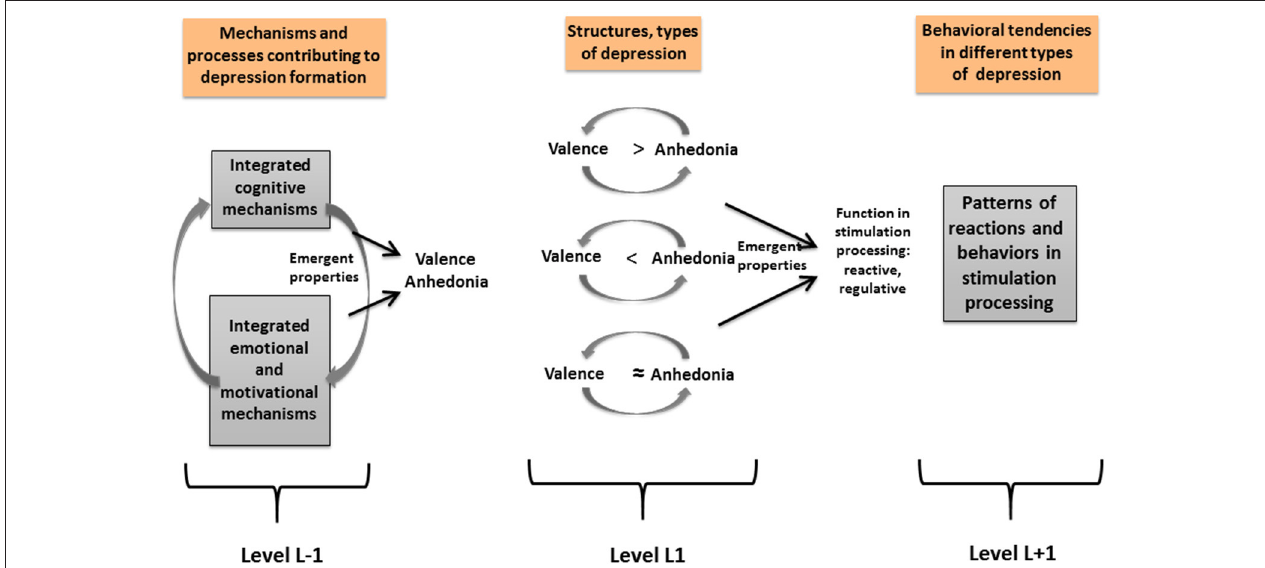
FIGURE 2 | The organization of depression types according to the three-level compositional hierarchy. Adapted from Fajkowska (2013), p. 118. Copyright by Eliot Werner, Clinton Corners, NY. Reprinted with permission.